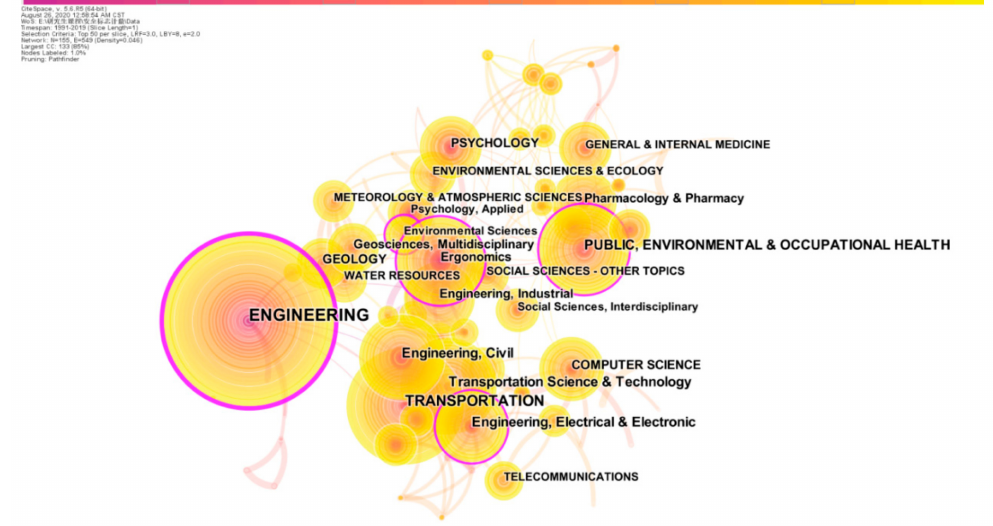
Figure 6. Category network of safety signs network.